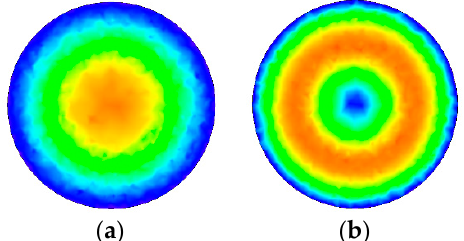
Figure 5. Magnetic field lines of shield of ferrite.